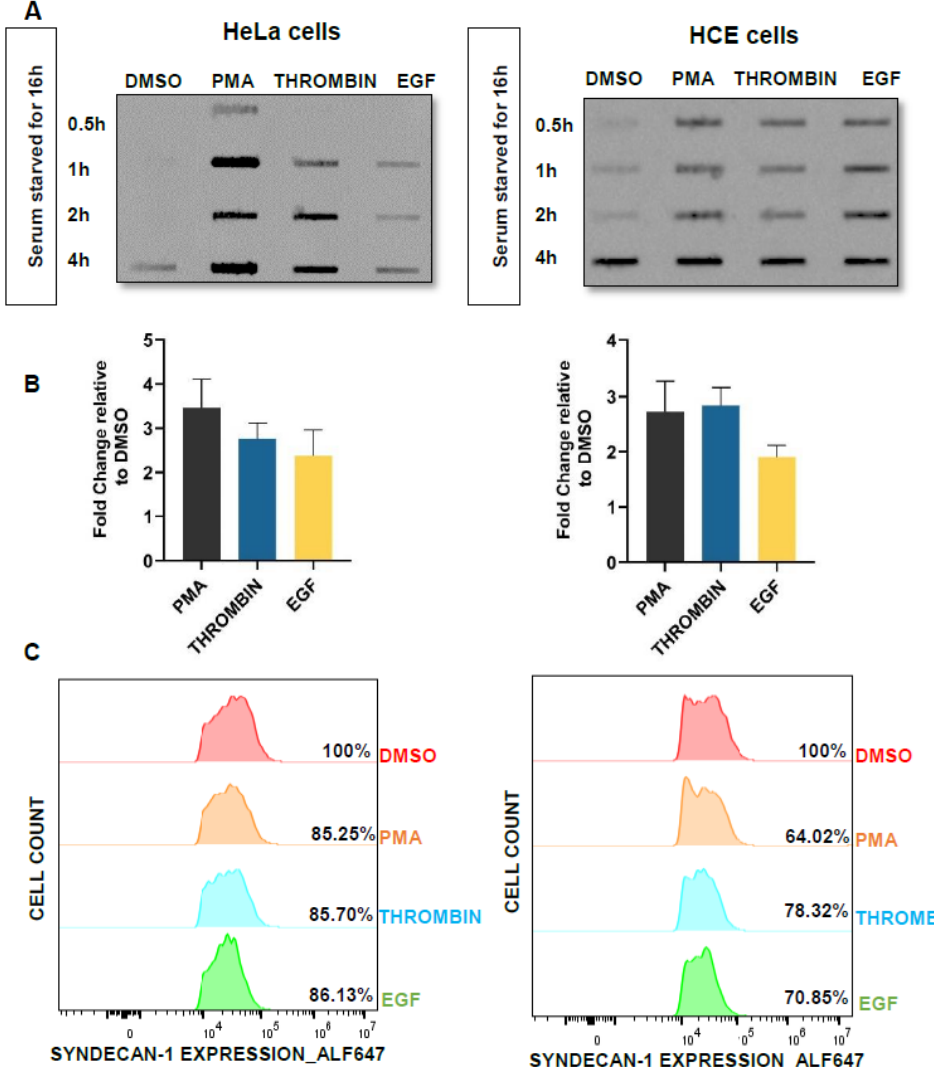
Figure 4. PMA, thrombin, and EGF treatment accelerates syndecan-1 shedding from HeLa and HCE cells’ surface to the culture supernatant. ( A ) HeLa and HCE cells were serum starved for 16 h. Then, cells were treated with DMSO, PMA, thrombin, or EGF in serum-free media. At 0.5, 1, 2, and 4 h time points, supernatant was collected. Shed syndecan-1 was evaluated by slot blot analysis. Results are representative of two independent experiments. Representative blots of two independent experiments are shown. ( B ) Densitometry quantification of the slot blot was performed using ImageQuant TL image analysis software. The results are shown as fold change of total syndecan-1 shedding after treatment with PMA, thrombin, and EGF in the supernatant over DMSO (control) cells. Representative graph of two independent experiments conducted in duplicate is shown. ( C ) Syndecan-1 expression in HeLa and HCE cells was measured using flow cytometry. Cells were infected HSV-1 (KOS) at an MOI of 0.1 for 2 h, and then, the media was changed into complete media for 8 h. Cells were further serum-starved for 12 h and then treated with DMSO (control), thrombin, PMA, or EGF for 4 h. After 4 h, cell lysates were collected and fixed with 4% PFA and then stained for syndecan-1. The results depict the decreased level of syndecan-1 expression on the surface of the cells treated with PMA, thrombin, and EGF than the DMSO (control)-treated